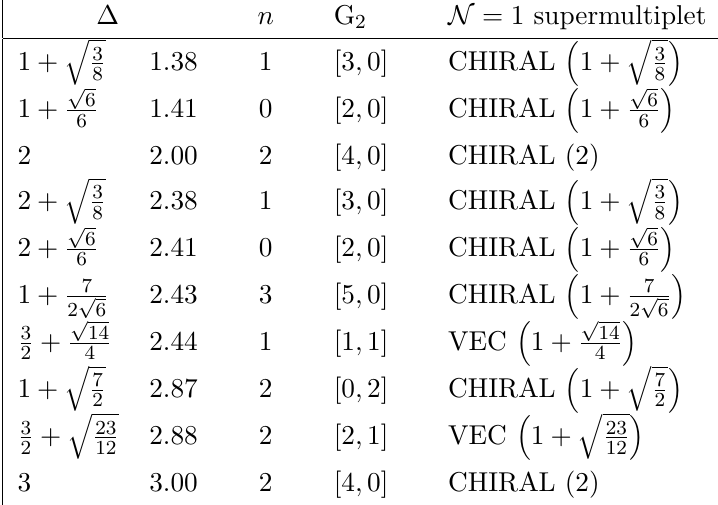
Table 6 . All KK scalars with dimension ∆ ≤ 3 around the D = 11 N = 1 G 2 -invariant AdS 4